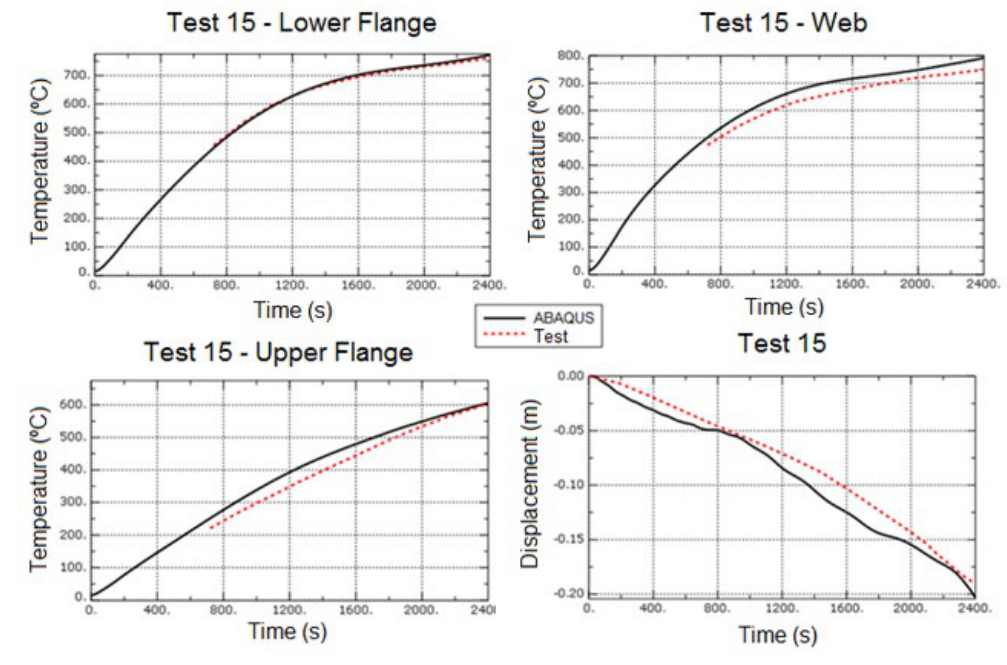
Figure 9. Numerical model compared to Test 15 results.